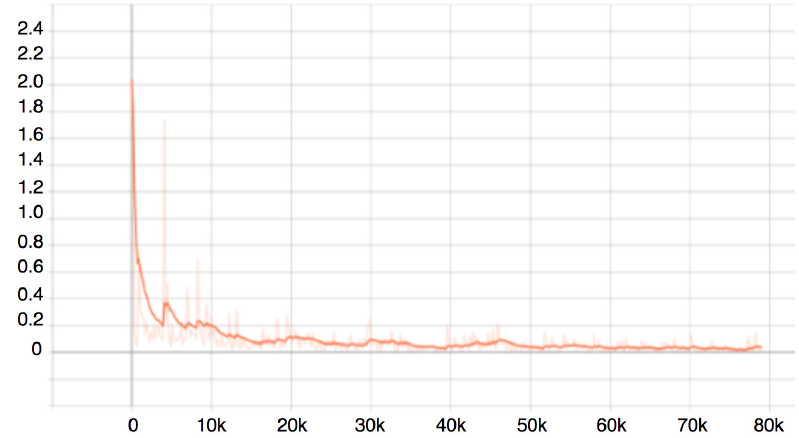
Figure 14. Loss values over training steps.